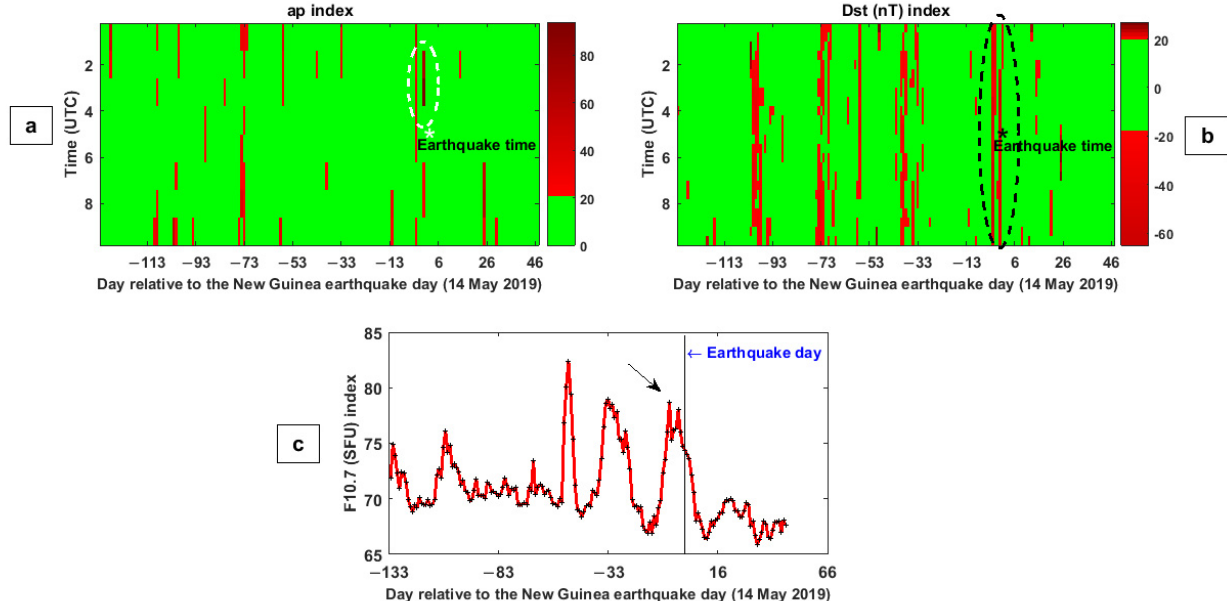
Figure 3. ( a – c ) shows, respectively, the variations of a p , D st , and solar radio flux (F10.7) indices, respectively, during the period of 1 January to 30 June 2019. An asterisk “*” indicates the earthquake time. The dotted ellipsoids represent the conditions around the earthquake time. The dotted line represents the earthquake day. An asterisk indicates the earthquake time of New Guinea (14 May 2019). The values of the geomagnetic indices are given as binary, i.e., red for disturbed magnetic times and green for quiet magnetic times.